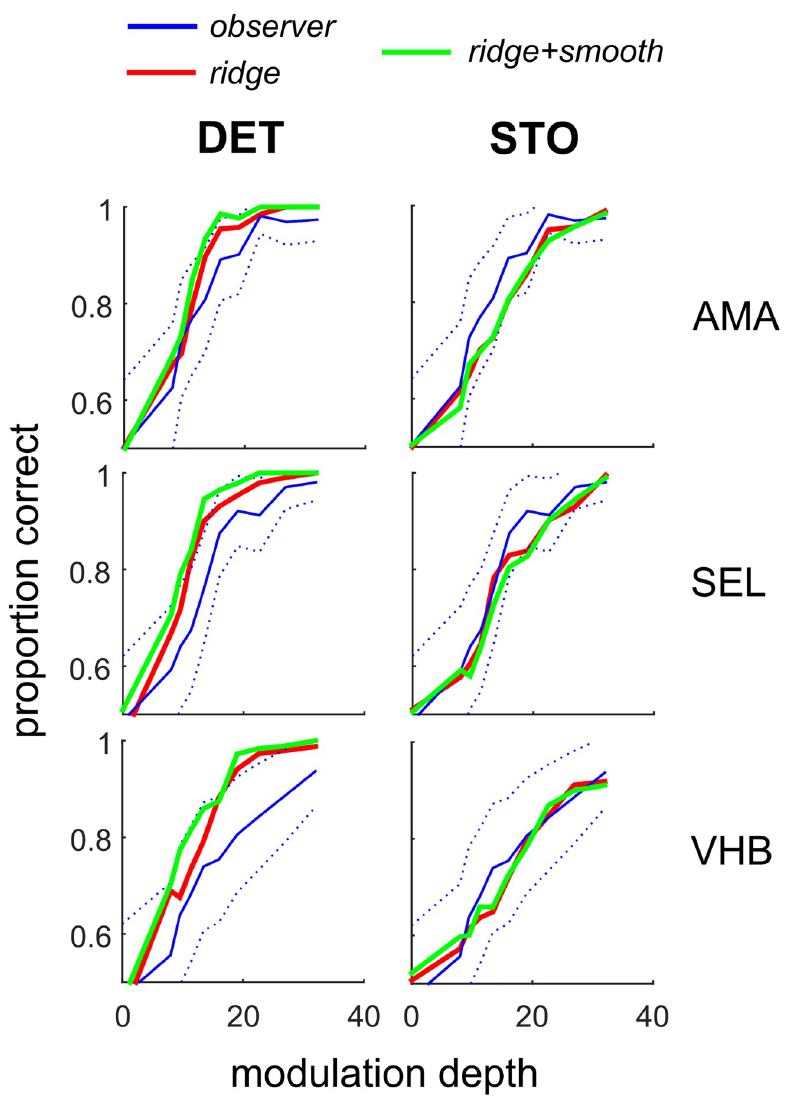
Fig 6. Psychometric functions for two versions of model (DET, STO), for three representative human observers (AMA, SEL, VHB) in Experiment 1-VAR. Blue lines denote human observer performance on the test set (stimuli not used for model estimation) as a function of modulation depth, together with 95% binomial proportion confidence intervals (+/- 1.96 SEM, blue dashed lines). Red and green lines denote model predictions for test stimuli for different Bayesian priors (red: ridge ; green: ridge + smooth ). Left column shows model operating deterministically (DET), right column shows model operating stochastically (STO).